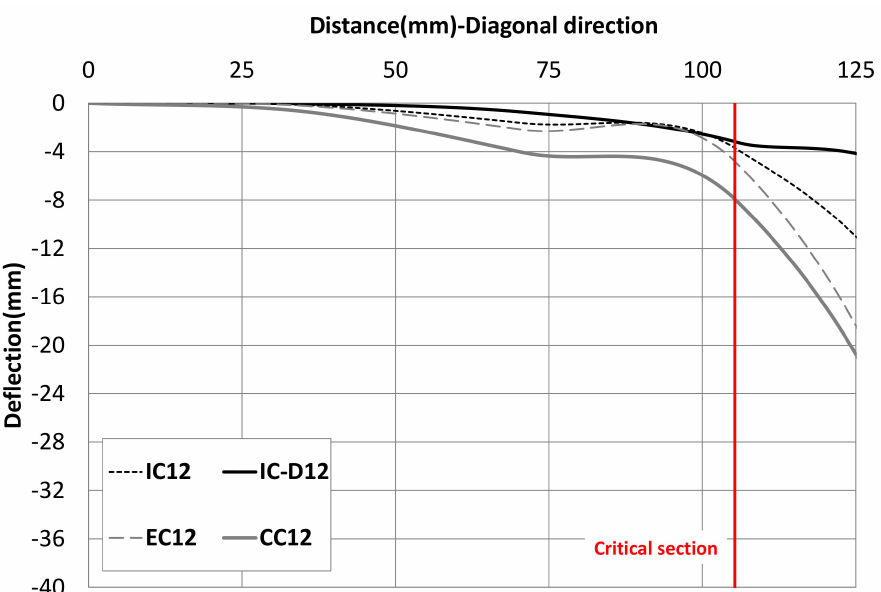
Figure 10. Slab deflection at the critical section with TNT 12 kg.